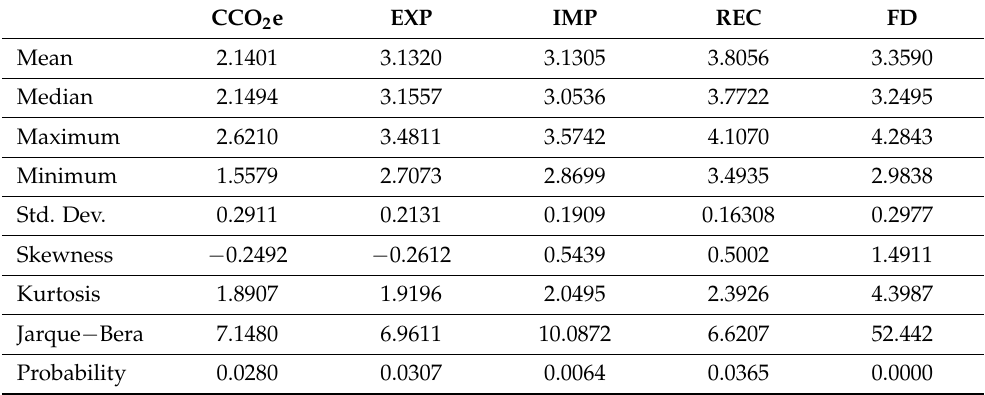
Table 2. Descriptive